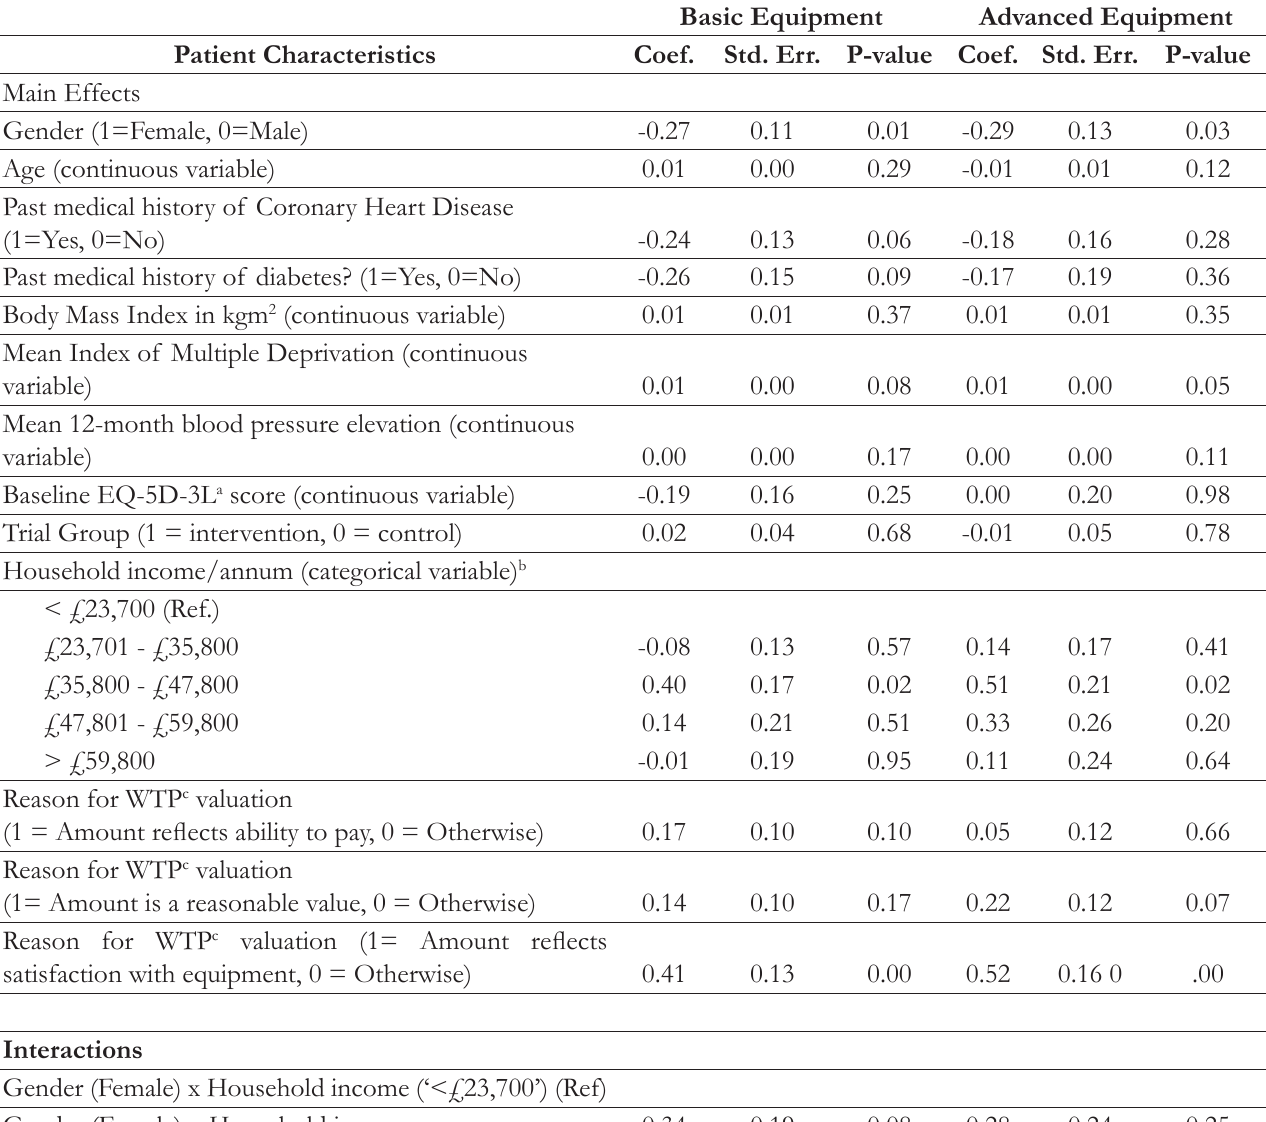
Table 3. GLM Regression Results (Predictors of Willingness-to-pay amounts) Basic Equipment Advanced